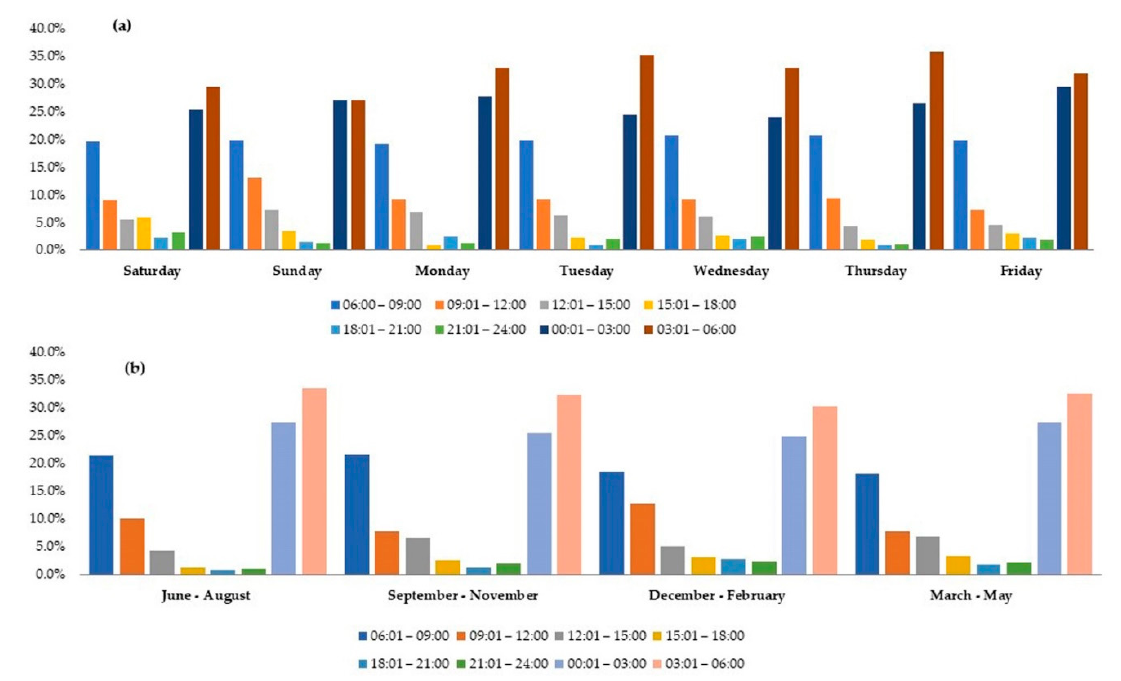
Figure 3. Analysis of time to ED presentation by weekdays vs. weekends and seasons of the year. Weekday vs. wed trends showed most of the patients being presented to ED on weekends and a significant percentage of patients presented during early morning hours ( a ). The seasonal breakdown of ED admissions is shown in ( b ) (June–August, September–November, December–February, and March–May).